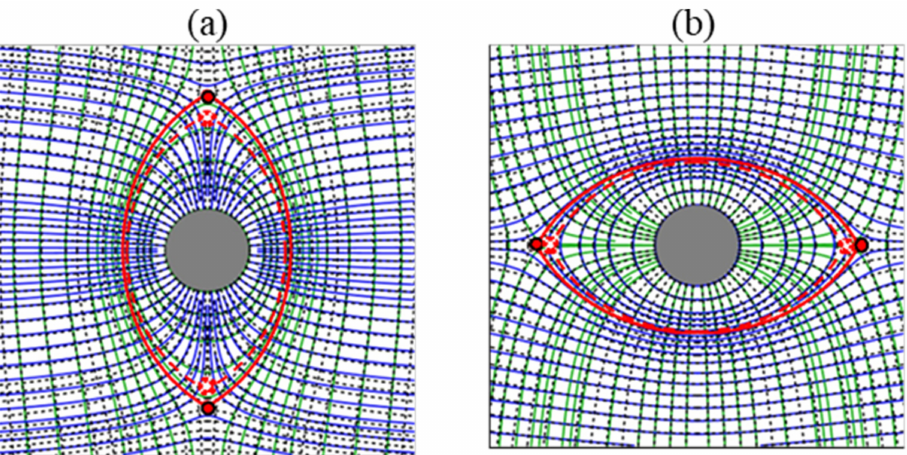
Figure 9. Stress trajectory patterns for wellbores. ( a ) Stress cage (dashed red upright ellipse) for P NET = +5 MPa. ( b ) Fracture cage (dashed red horizontal ellipse) for P NET = − 5 MPa. Modified from Wang and Weijermars [29]. A far-field anisotropic stress field is present, with the largest compressional principal stress trajectories outlined in blue and the least principal stress trajectories outlined in